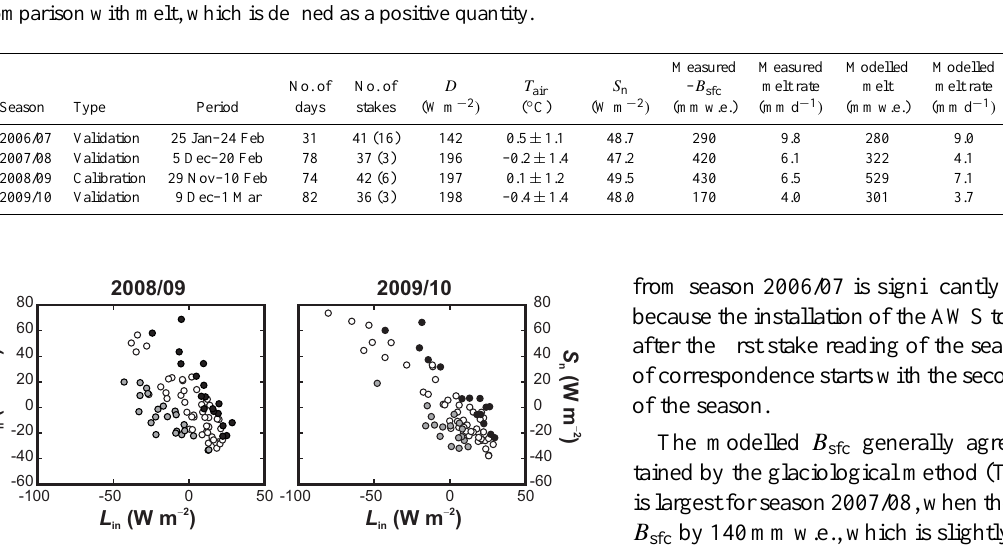
Fig. 7. Daily mean offset to the seasonal mean L in versus corre- sponding S n for melt seasons 2008/09 and 2009/10. Black dots indicate days when A was larger than 150% of seasonal mean A , grey dots when lower than 50% and white dots when A was be- tween 50% and 150%.